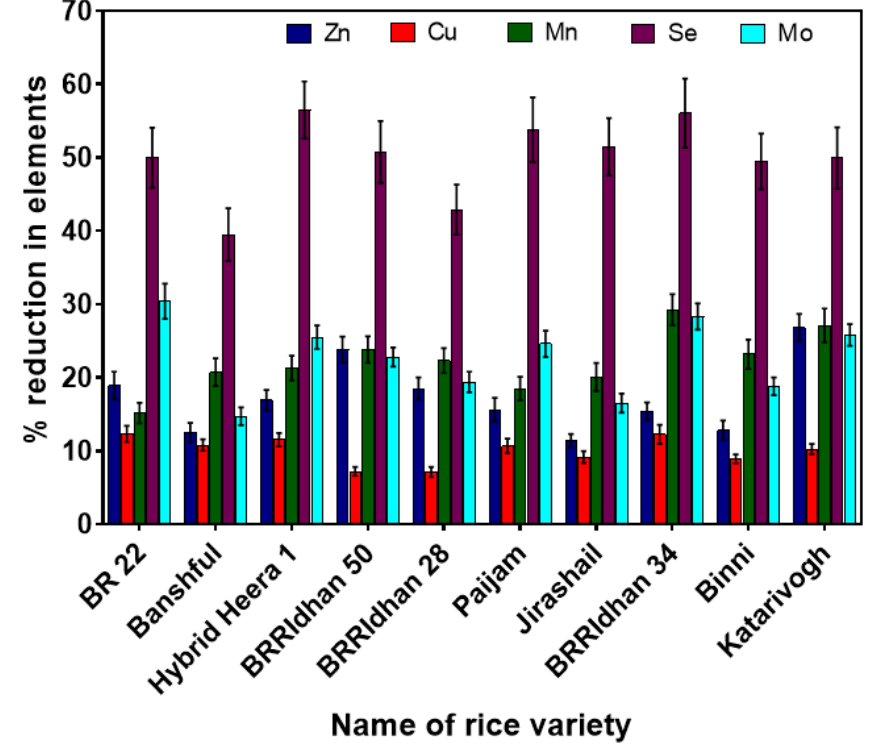
Figure 3. Influence of various cooking procedures on removal of different essential nutrient elements (Zn, Cu, Mn, Se, and Mo) from raw rice.